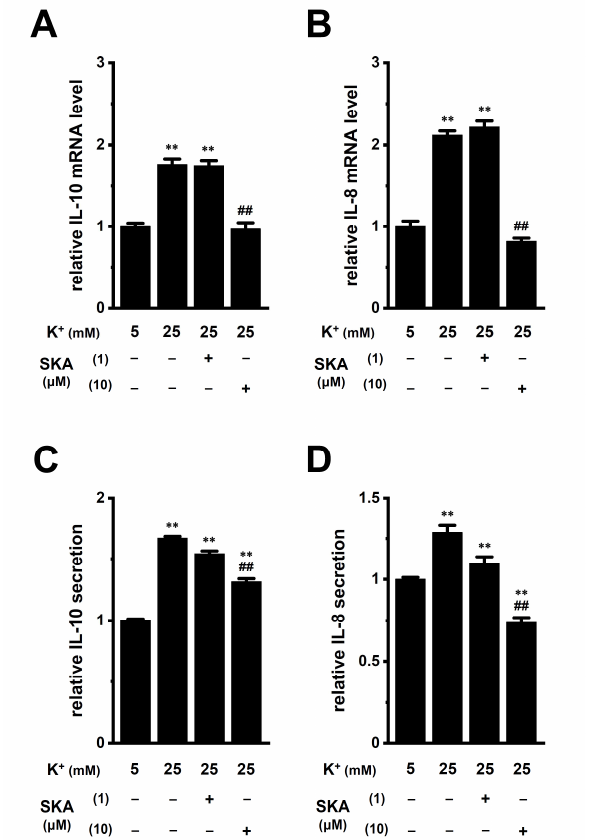
Figure 5. Effects of treatment with SKA-121 on high [K + ] e -enhanced IL-10 and IL-8 expression and secretion in THP-1-derived M 2 macrophages. A,B: Real-time PCR examination of IL-10 ( A ) and IL-8 ( B ) expression in normal [K + ] e (5 mM)- and high [K + ] e (25 mM)-treated THP-1-derived M 2 macrophages for 24 h in the presence (+) or absence (−) of SKA-121 (1, 10 μM). Relative mRNA expression in normal [K + ] e is expressed as 1.0 (n = 4 for each). ( C , D ): Quantitative detection of IL-10 ( C ) and IL-8 ( D ) secretion by an ELISA assay in THP-1-derived M 2 macrophages treated and untreated with SKA-121. Relative cytokine secretion in normal [K + ] e is expressed as 1.0 (n = 4 for each). **: p < 0.01 vs. normal [K + ] e , ## : p < 0.01 vs. the vehicle control (−/−) of high [K + ] e .